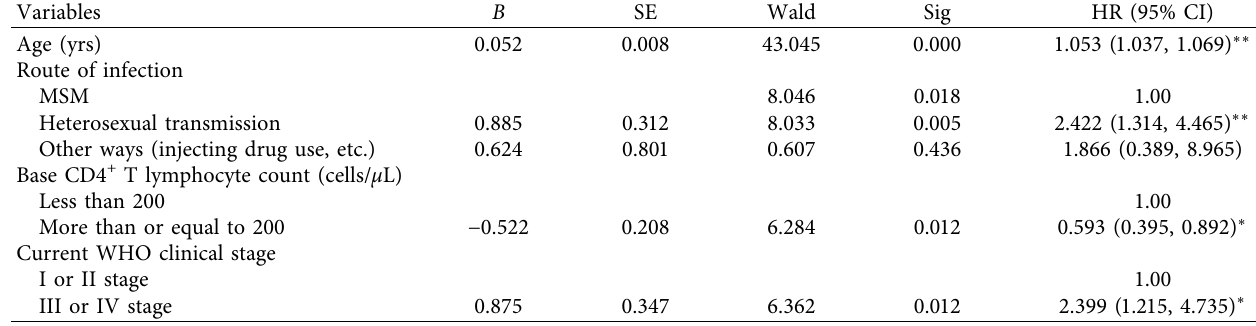
Table 2: Results of multivariate Cox proportional hazards regression model